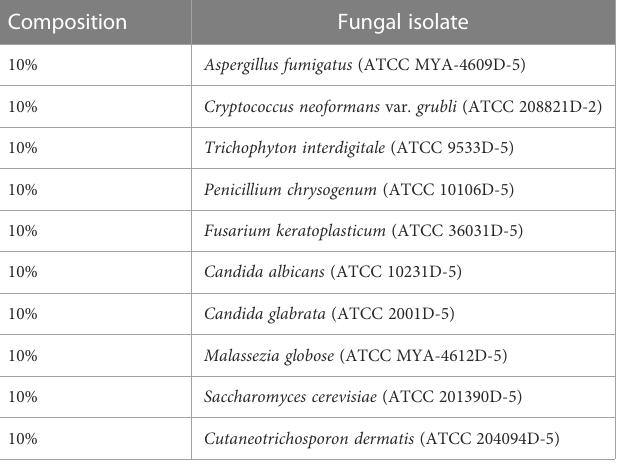
TABLE 3 Composition of fungal genomic DNA found in ATCC MSA 1010 mix (ATCC Reference